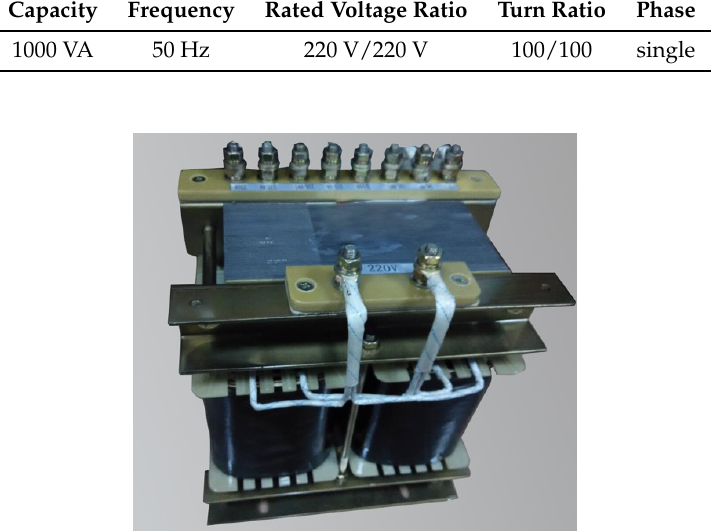
Figure 9. Transformer used in experiment set 2.